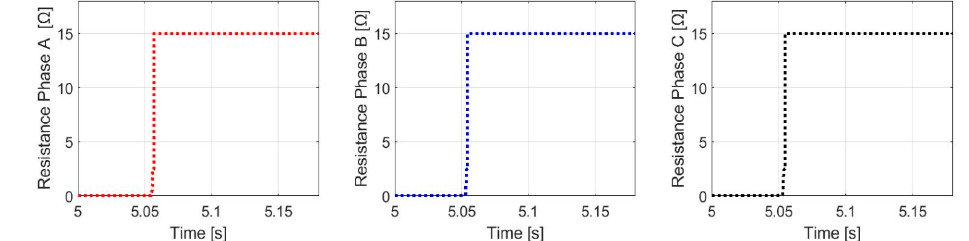
Figure 9. Equivalent resistance for phases A, B, and C for 3-Phase-to-ground solid fault at 50% of cable’s length.